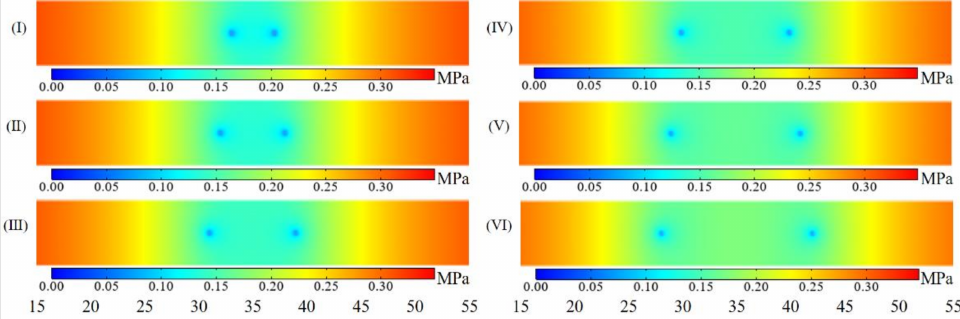
Figure 24. Cloud chart of gas pressure distribution around boreholes with different borehole spacing: ( I ) 4 m; ( II ) 6 m; ( III ) 8 m; ( IV ) 10 m; ( V ) 12 m; ( VI ) 14